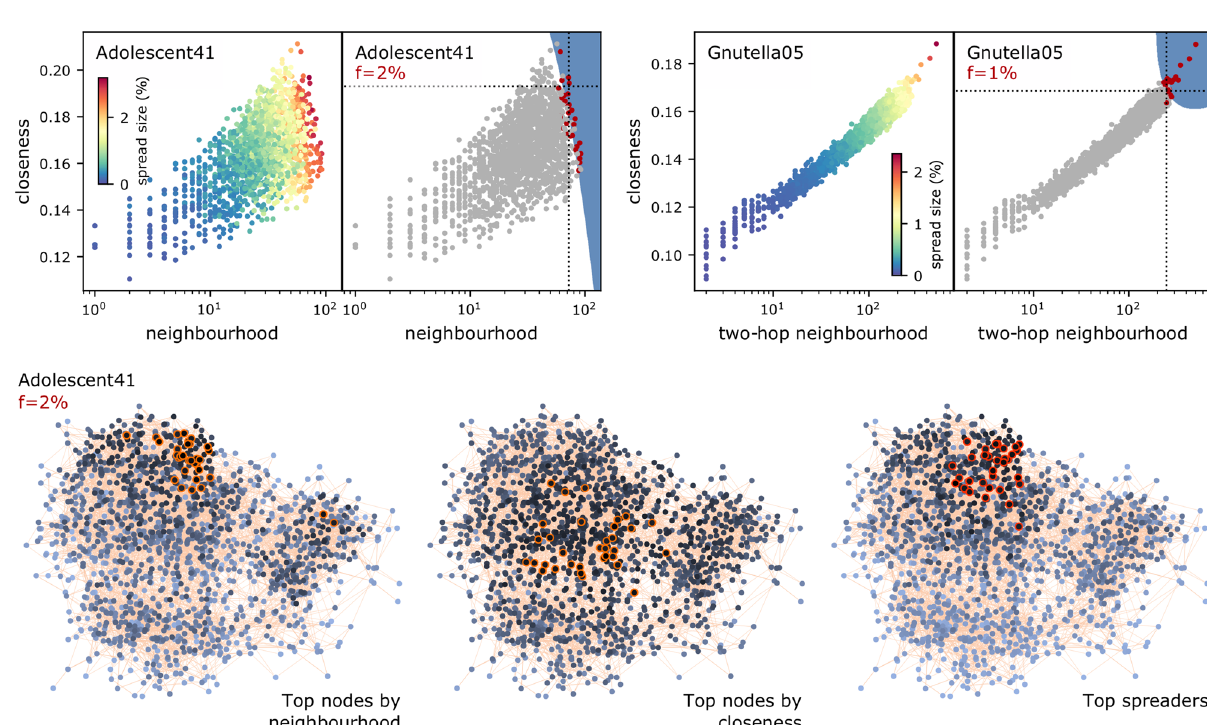
Figure 8. As Fig. 6, for closeness combined with another